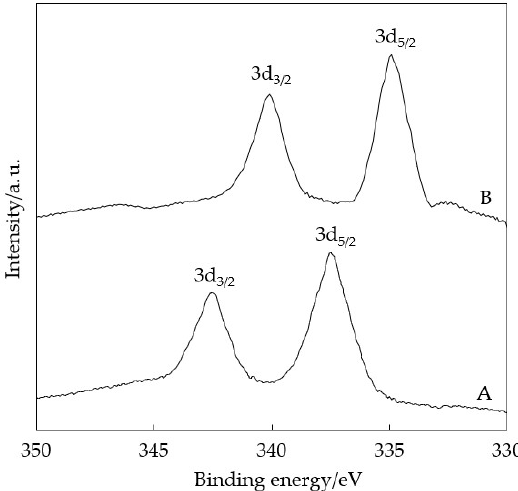
Figure 8. XPS spectra of Pd-PW-HAP before and after reaction. (A): Pd-PW-HAP before reaction; (B): Pd-PW-HAP after reaction at 363 K for 8 h.